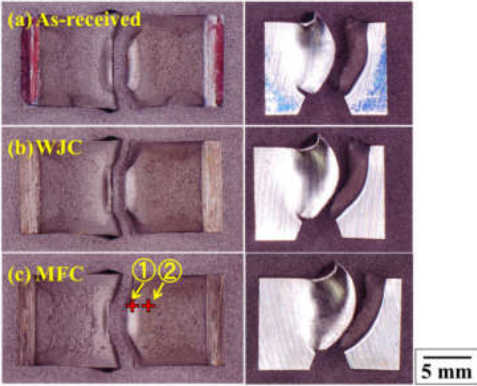
Figure 1. Optical microscope images for the Cr–Mo steel (SCM435) Charpy impact test. (WJC: water jet cavitation; MFC: multifunction cavitation.)